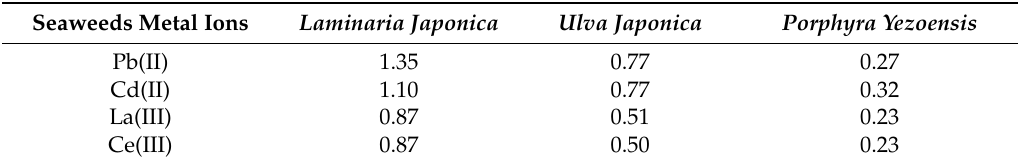
Table 3. Maximum adsorption capacities for Pb(II), Cd(II), La(III), and Ce(III) for the biosorbents